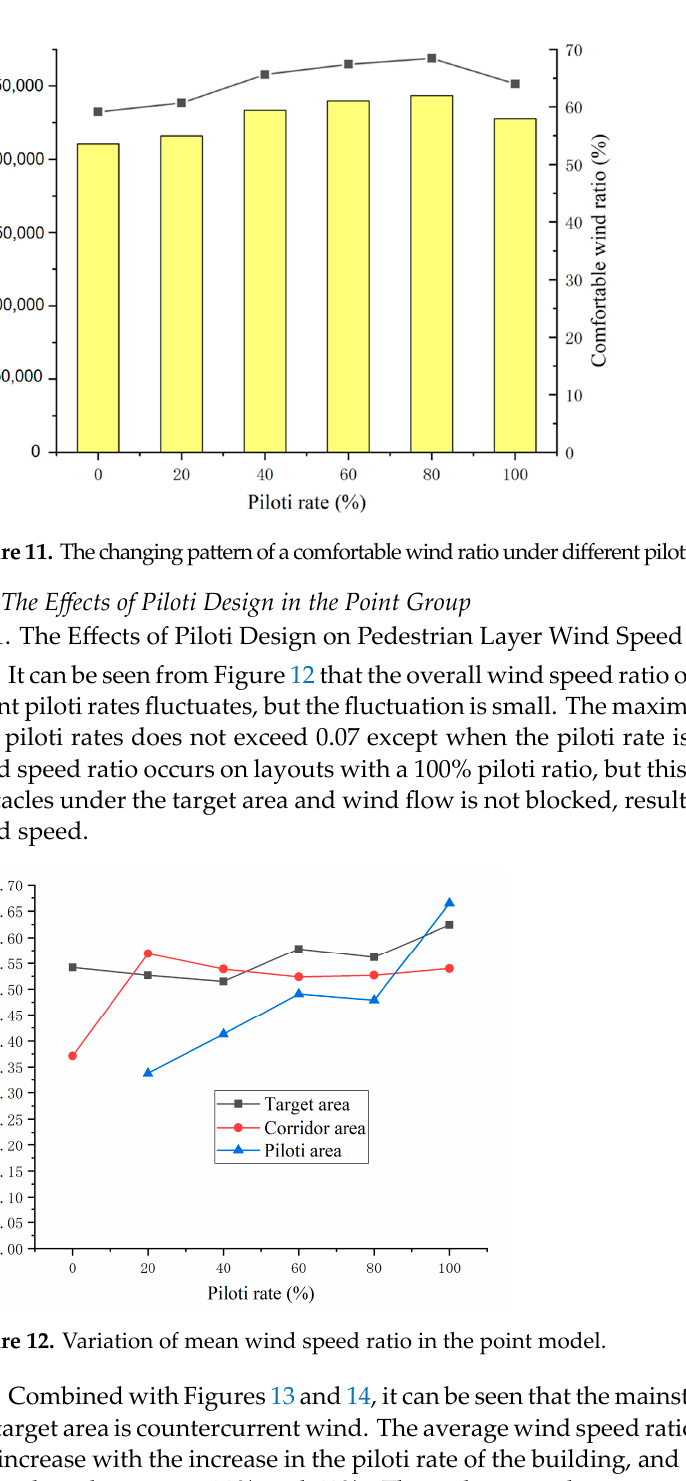
Figure 11. The changing pattern of a comfortable wind ratio under different piloti rates (Determi- nant model).